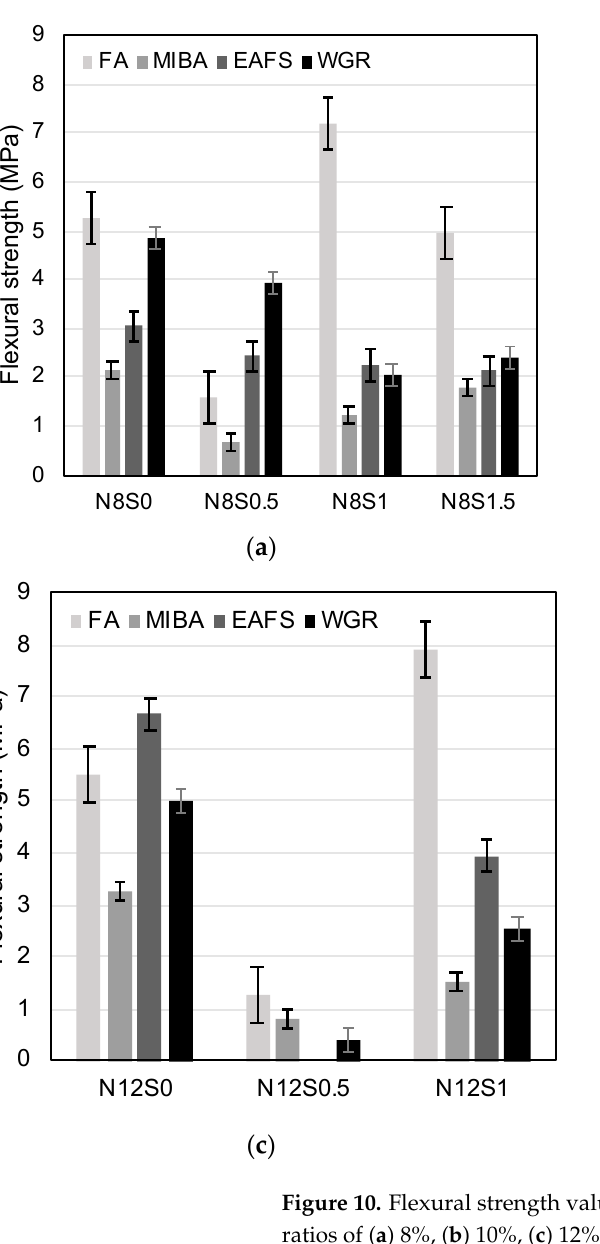
given compressive strengths, compared to mortars with OPC as a binder [92].